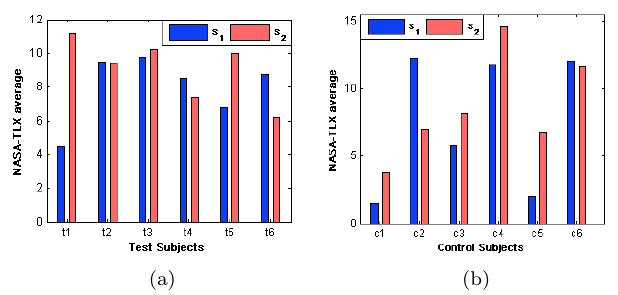
Figure 3: NASA-TLX response: (a) Subjects in test group (b) Subjects in control group.